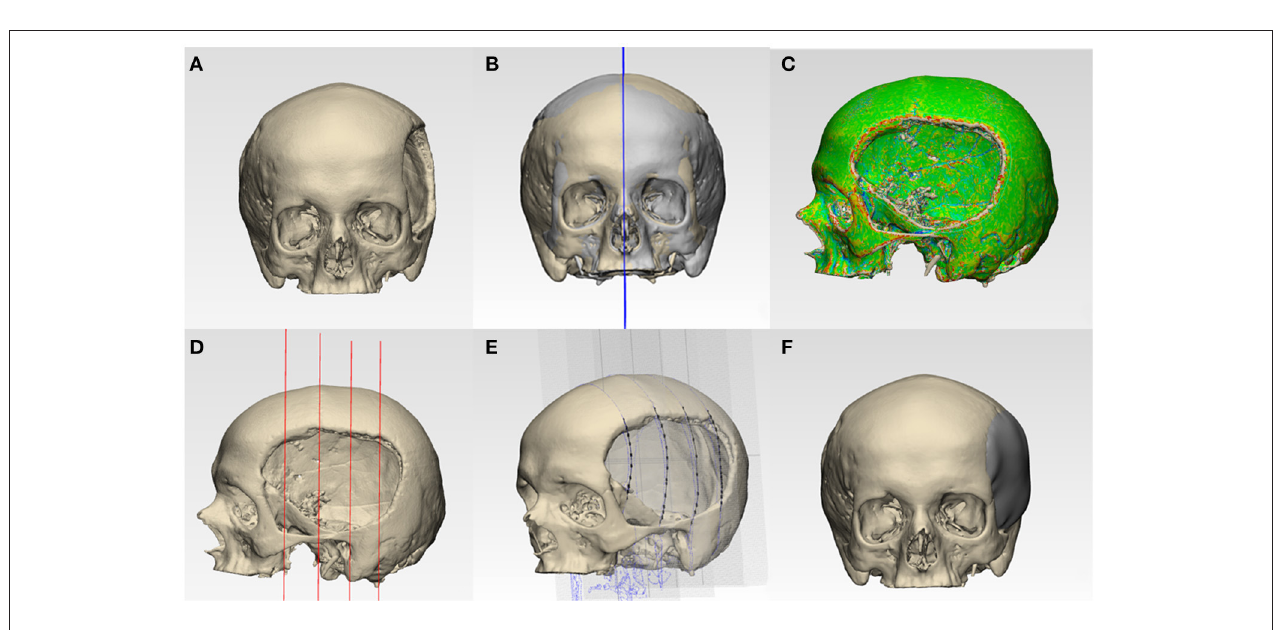
FIGURE 2 | Schematic representation of steps involved in the anatomical design modeling phase for reconstructing a patient-specific cranial prosthesis. (A) Three-dimensional (3D) volumetric reconstruction of the skull model. (B) Creation of a datum plane and mirroring of the healthy side onto the defect side. (C) Curvature analysis and optimization of a curve. (D) Equidistantly spaced sketch graphs oriented perpendicular to the datum plane. (E) Spline creation by the importation of contour reference data from the curve, mirrored, and defect side. (F) Reconstructed skull with the cranial